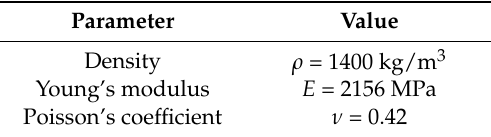
Table 1. Parameters of clear PVC film.